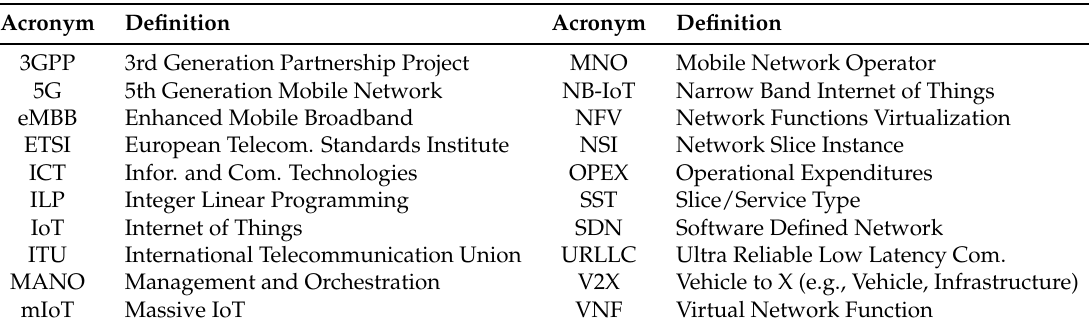
Table 2. List of abbreviations and corresponding